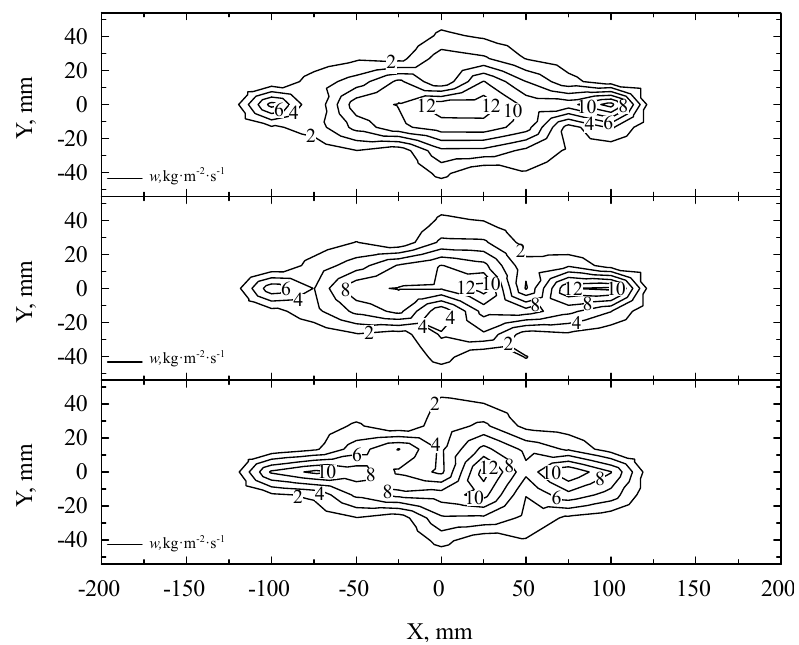
Figure 2. Experimental reproducibility of impingement density maps through nozzle 632.604.